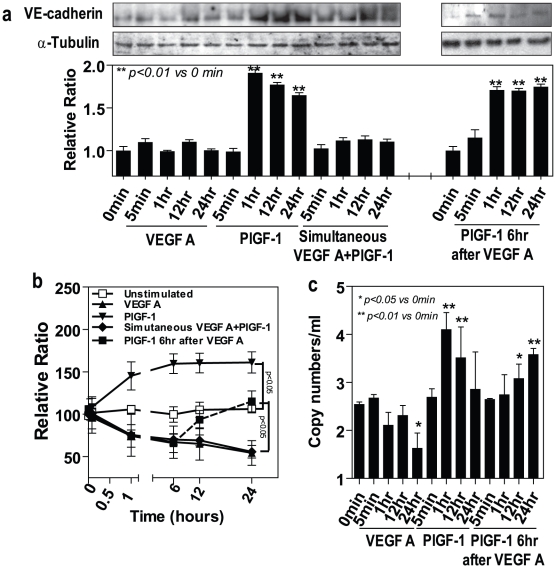
PlGF-1 promotes expression of VE-cadherin and reduces cleavage of cell surface VE-cadherin and regulates VE-cadherin expression.Confluent microvascular endothelial cultures were exposed to VEGFA; hPlGF-1; simultaneous VEGFA + hPlGF-1; VEGFA followed by hPlGF-1 6 hours later and assessed for total VE-cadherin expression by Western blot. VEGFA and hPlGF-1 were used at 100 ng/ml. (a) Top: representative immunoblots for VE-cadherin and, upon reblot, α-tubulin. Bottom: laser densitometry analysis demonstrating the relative ratio of VE-cadherin to the house keeping protein α-tubulin (n = 3 independent experiments). (b) The level of cell surface VE-cadherin on microvascular endothelial cells determined using a cell-based ELISA. Values were calculated as the percent relative to the unstimulated group (n = 4 independent experiments). (c) VE-cadherin mRNA levels quantified using QRT-PCR. Values are displayed as mean transcript copies normalized against GAPDH as the housekeeping gene (n = 3 independent experiments). Data are represented as means ± s.e.m. *p<0.05, ** by p<0.01 (Mann-Whitney U test).